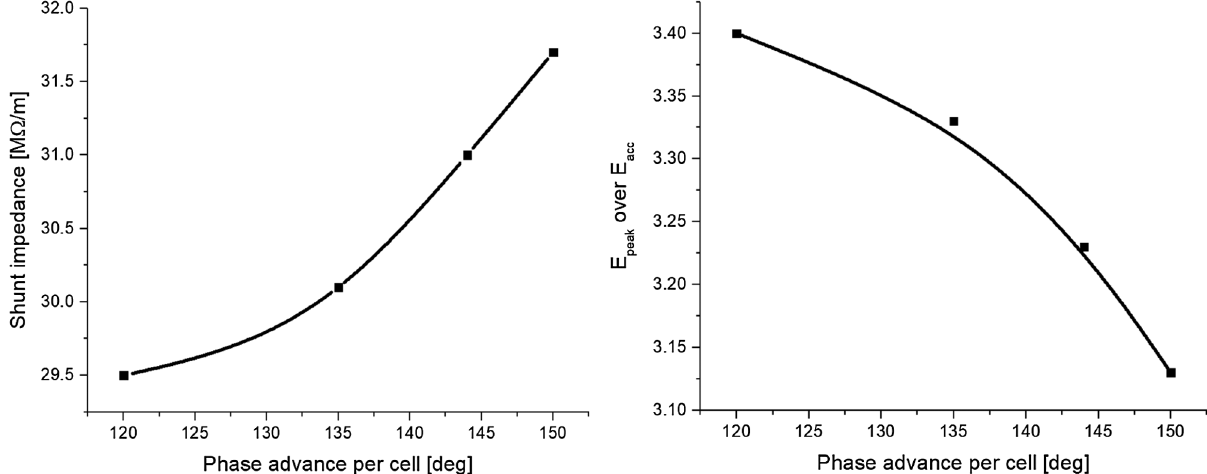
FIG. 12. Shunt impedance (left) and peak field normalized to the accelerating gradient (right) of the NHS structure with noses as a function of designed operation